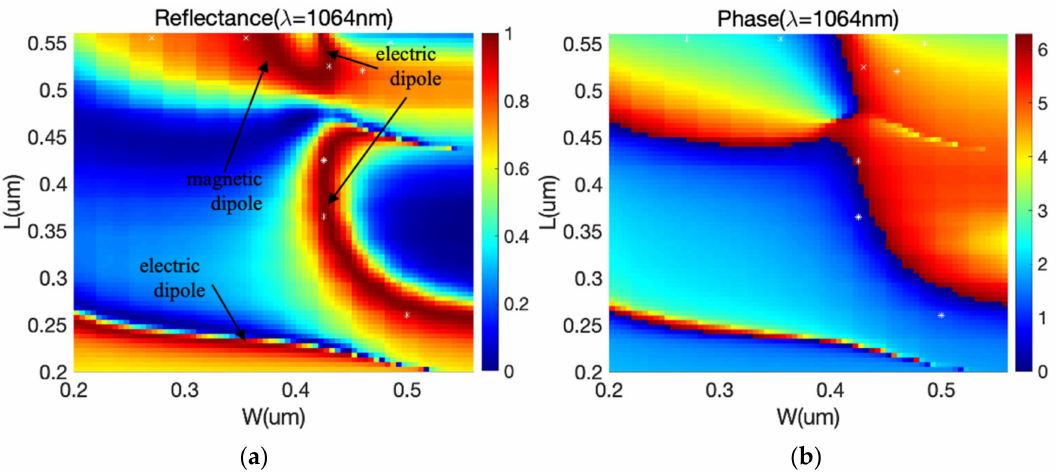
Figure 2. Optical properties of the unit-cells of Si nanoholes: ( a ) reflectance and ( b ) phase of light reflected by the unit-cells as a function of L and W . Here, the height H is 200 nm, and the lattice period P is 600